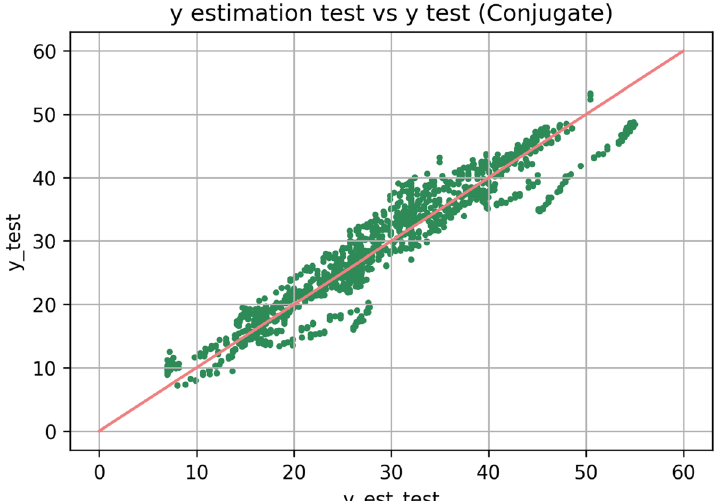
Fig. 11 y estimation test vs y